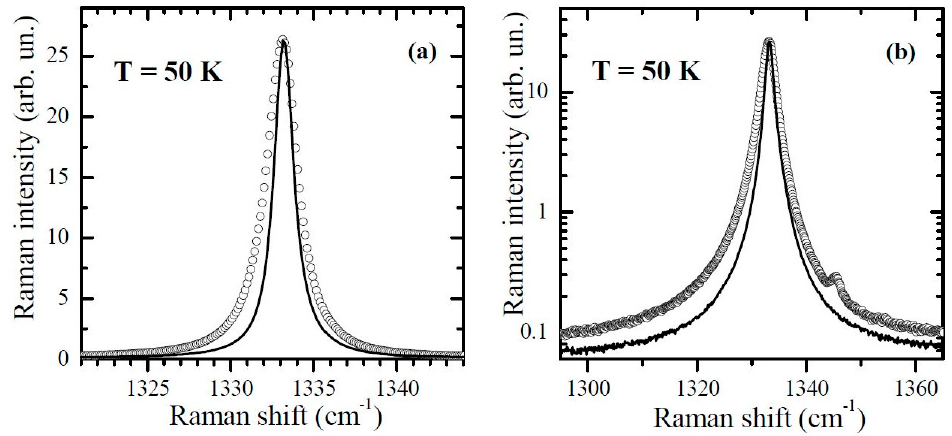
Figure 1. Raman line of the nitrogen-containing diamond (circles) and of the defect-free diamond (line) at T = 50 K: ( a ) linear scale for the intensity; ( b ) logarithmic scale for the intensity.